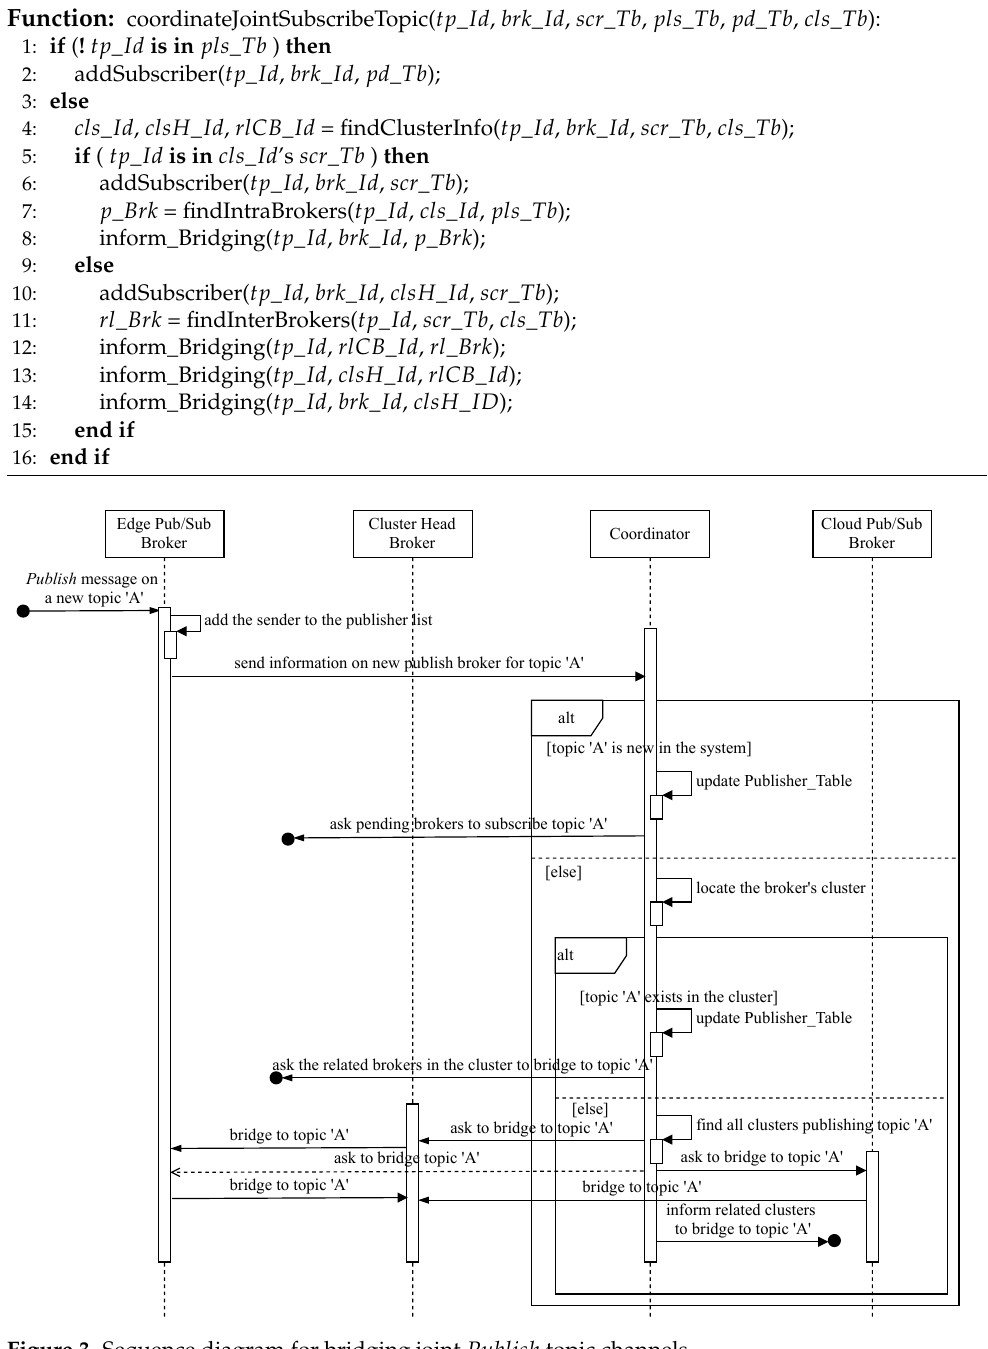
Figure 3. Sequence diagram for bridging joint Publish topic